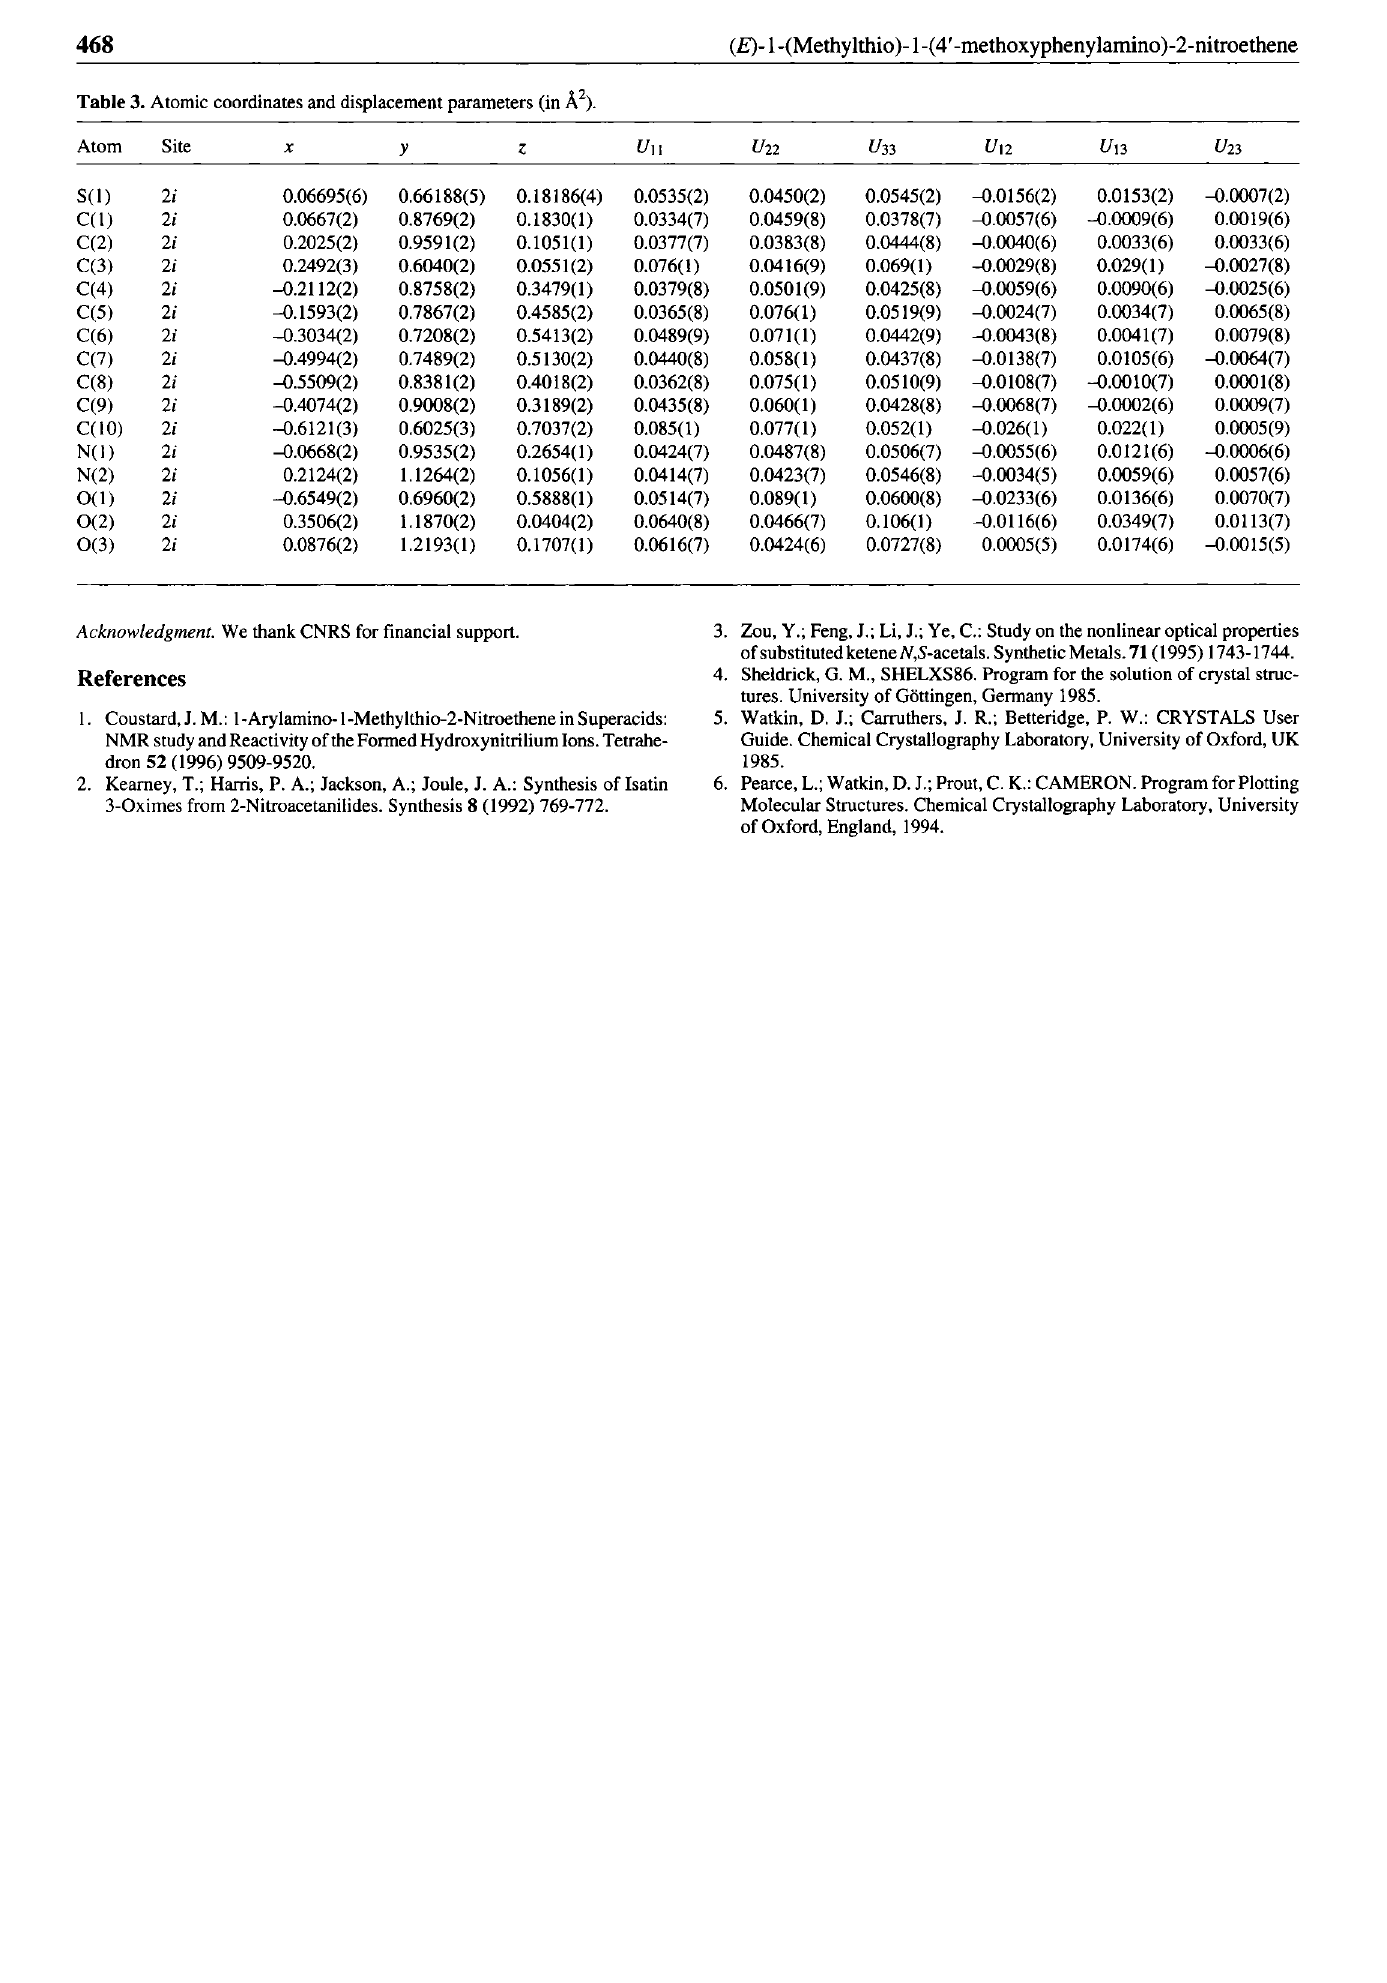
Table 3. Atomic coordinates and displacement parameters (in Ä 2